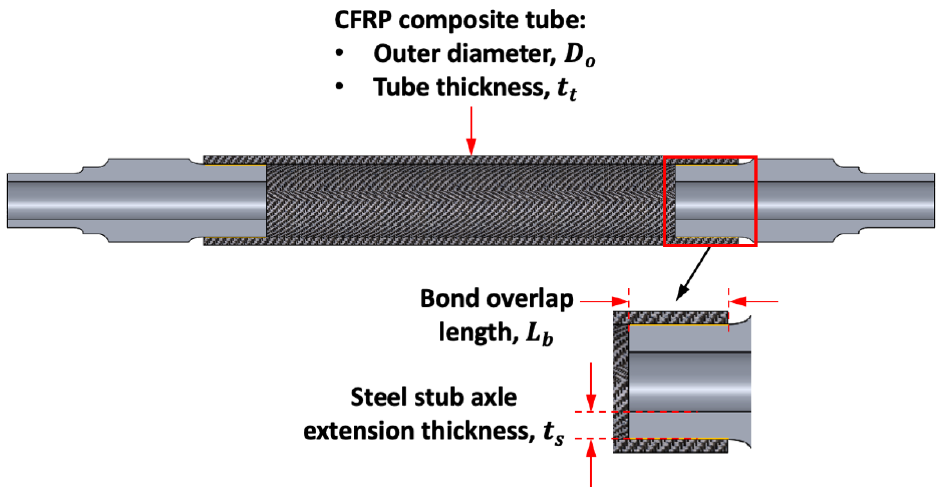
Figure 5. Illustration of the parameters for optimisation of the structural hybrid metallic-composite railway axle assembly.